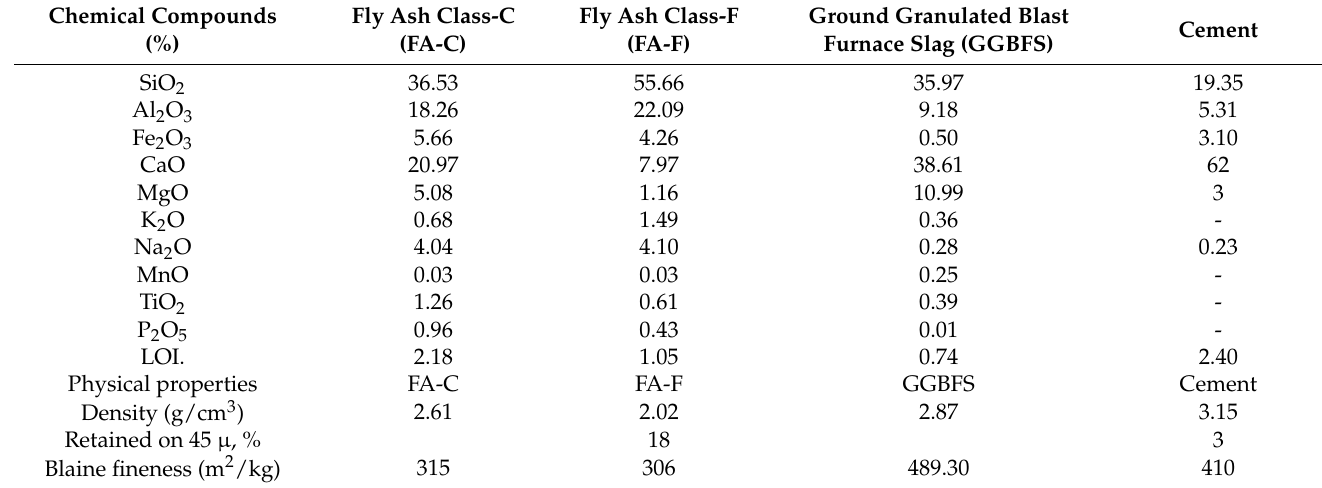
Table 1. Chemical composition and physical properties of source materials and